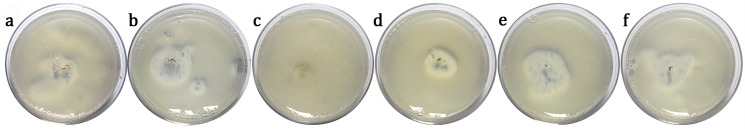
Calcite dissolution induced by fungal growth and metabolism in cultures (day 21, CaCO3 glucose agar):
Penicillium lanosum BEOFB 1161m (a); Aspergillus niger (b); A. europaeus (c); P. bilaiae (d); P. rubens (e); P. commune (f).